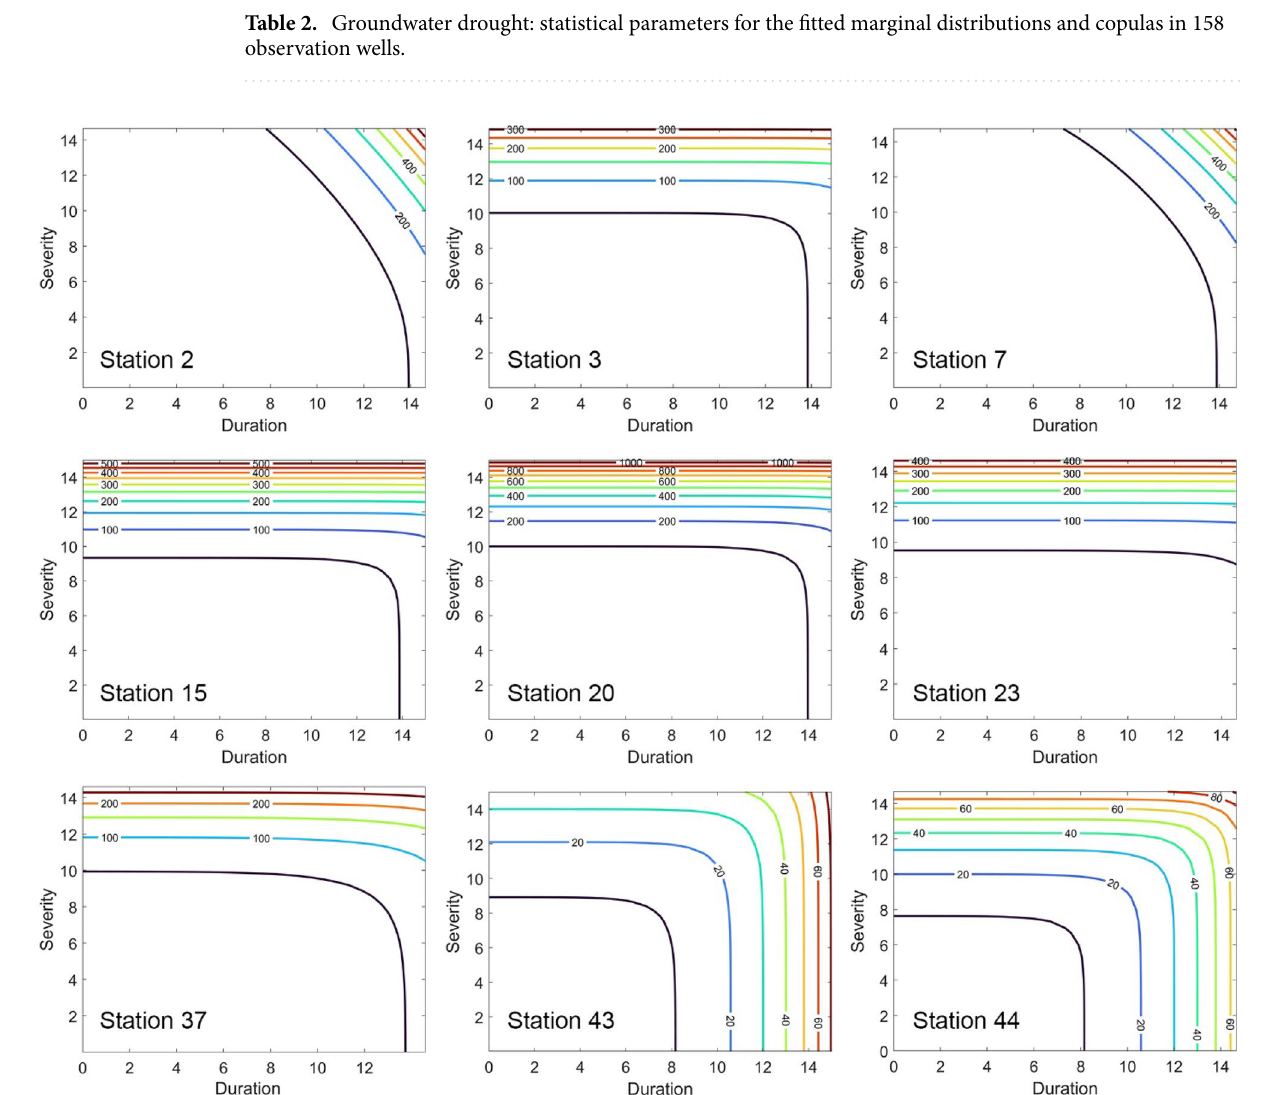
Figure 2. Bivariate return period for Met drought for a sample of stations based on fitted